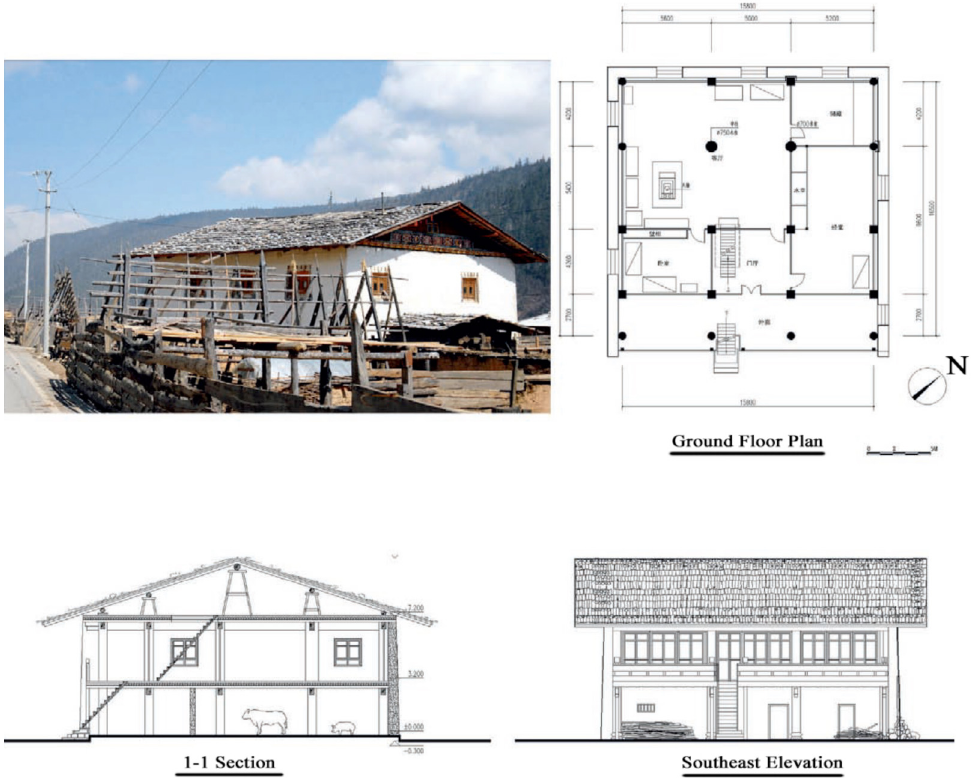
Fig. 4. Sun Nuo's dwelling in Hongpo Village, Jiantan